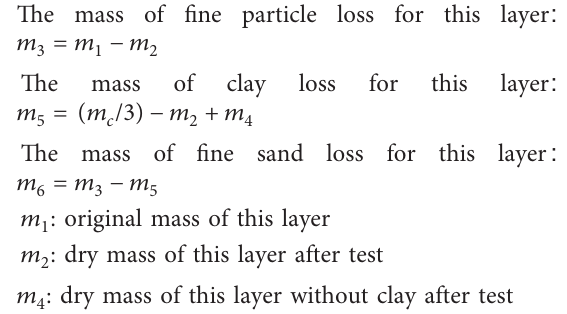
m : dry mass of this layer without clay after test 4